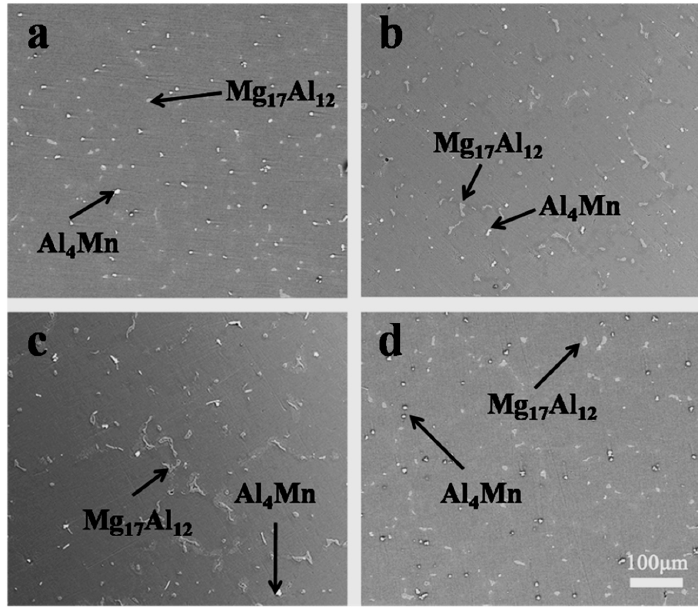
Figure 5 . Section of Mg-0.5Mn-Al system calculated using the Pandat software.